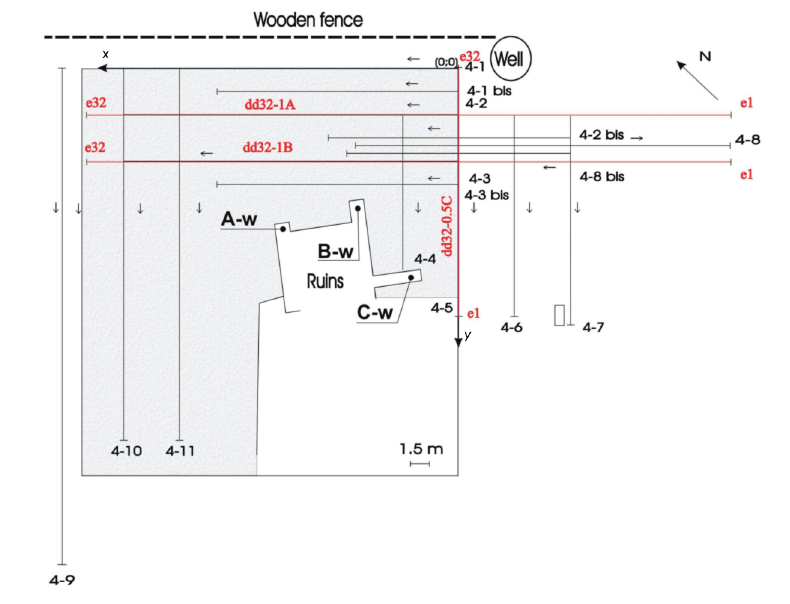
Fig. 2. Acquisition scheme: GPR profile (black lines); geoelectric tomography (red lines); magnetic survey (gray area).